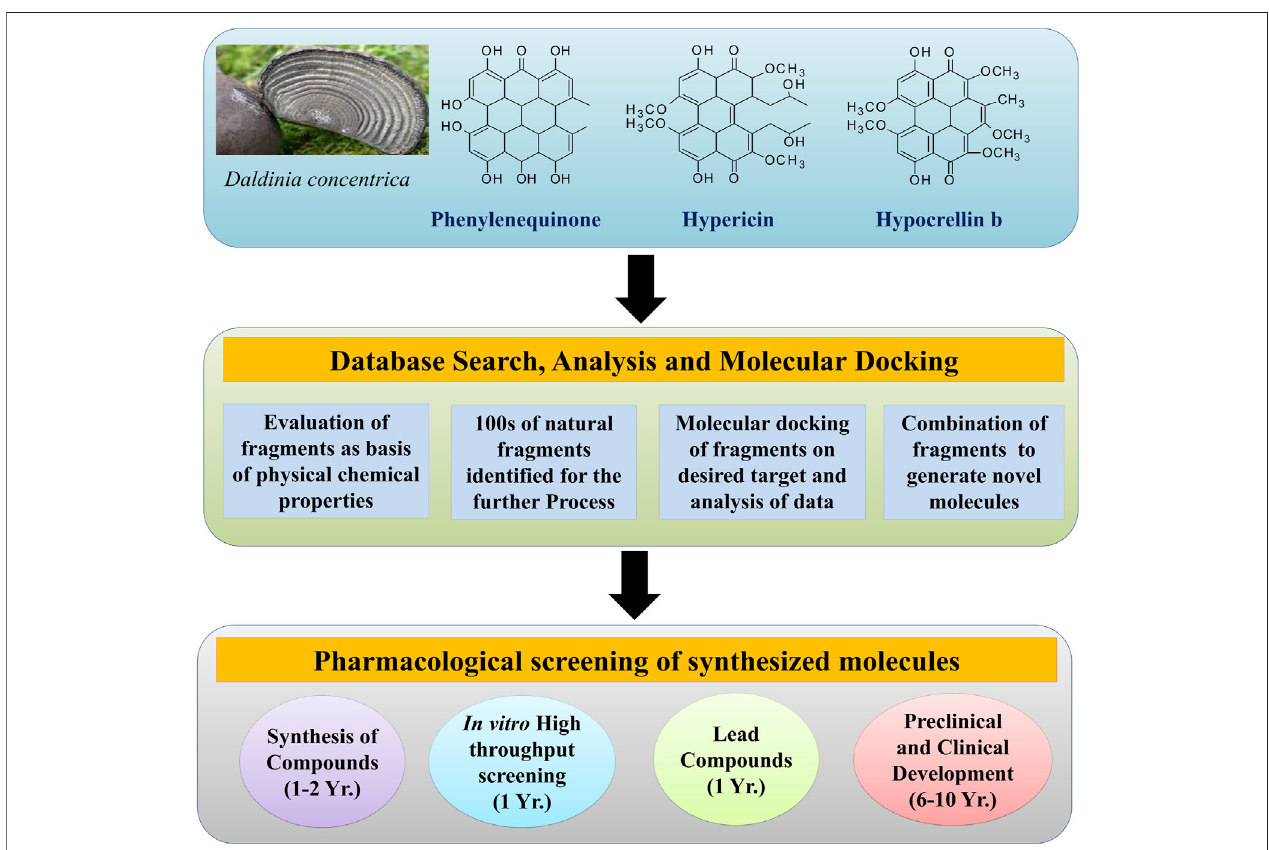
FIGURE 4 | Procedure for fragment-based